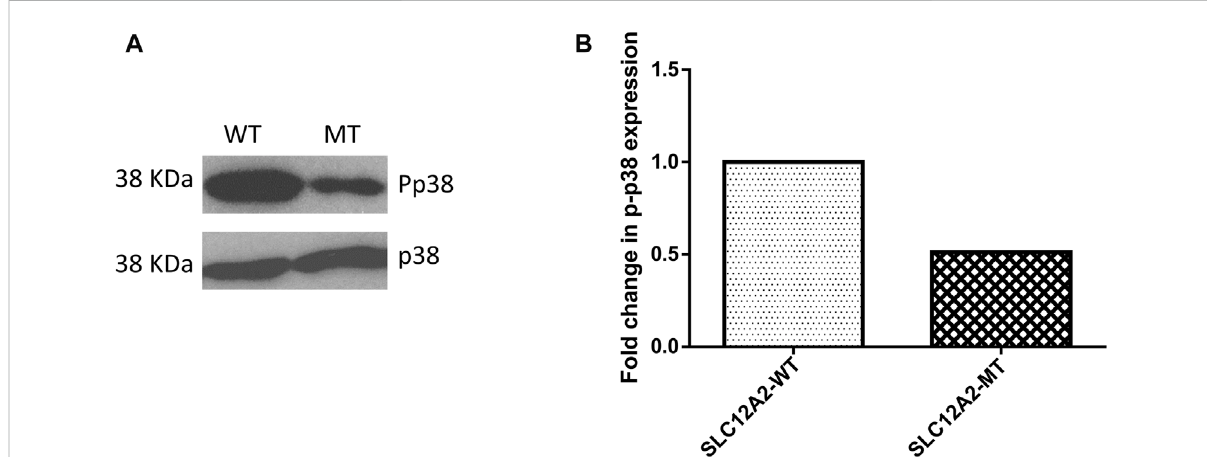
FIGURE 4 Mutant (MT) SLC12A2 expressing cells had relatively less phosphorylated p38 (Pp38) compared to the wild type (WT). (A) Western blot showing Pp38 expression in HEK293 cells transfected with WT and (C) 2935G > A: p.(E979K) MT SLC12A2 plasmids. Total p38 was used for normalization